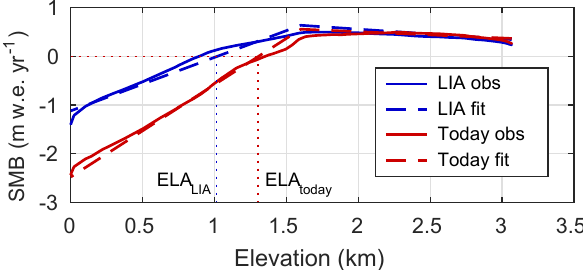
Figure 2. SMB profiles along Jakobshavn Isbræ’s main flow line at the LIA (1840–1850 average) and present day (2002–2012 av- erage) from observations by Box (2013) and the linear fit used in the model. Thin dotted lines show position of the equilibrium line altitude (ELA) for the present-day and LIA